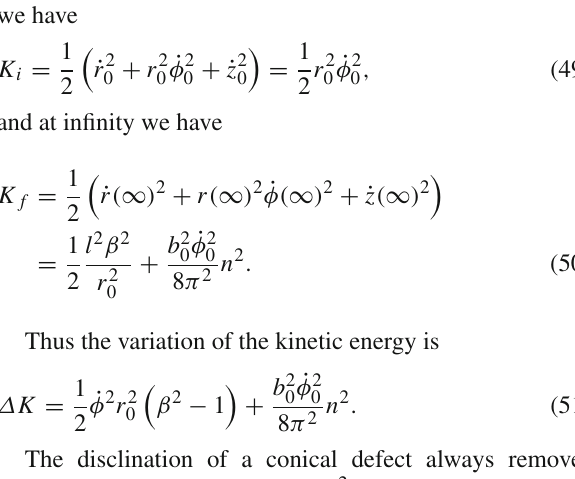
[20,21]. This possibility implies the existence of a discrete energy for the gravitational field of the defect and, conse- quently, a discrete disclination